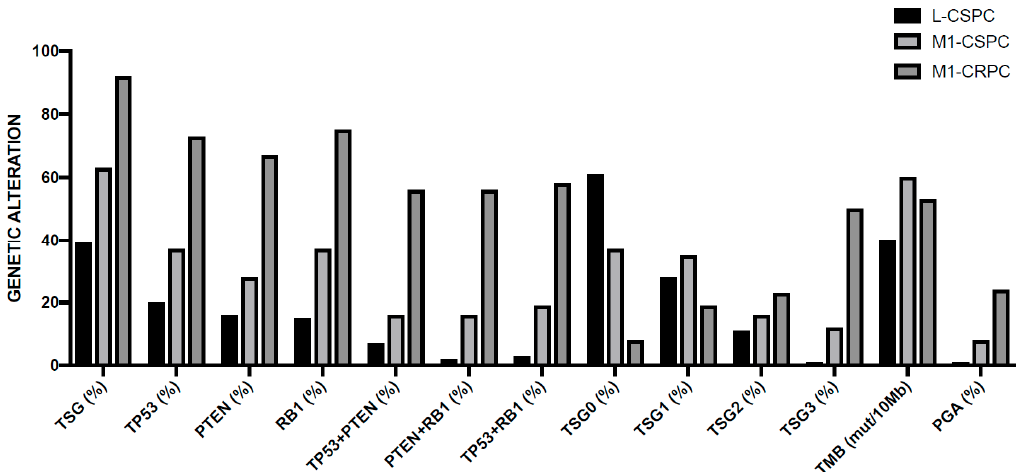
Figure 5. Frequency and distribution of genetic alterations of PTEN, RB1 and TP53 genes and measures of genomic instability in three groups of prostate cancer patients: L-CSPC (Localized Castration-Sensitive Prostate Cancer), M1-CSPC (Metastatic Castration-Sensitive Prostate Cancer), and M1-CRPC (Metastatic Castration-Resistant Prostate Cancer). TSG: Tumor Suppressor Gene. TMB: Tumor Mutation Burden. PGA: Percent of Genome Copy number Altered. Data are reported from Hamid et al., 2019 [233].